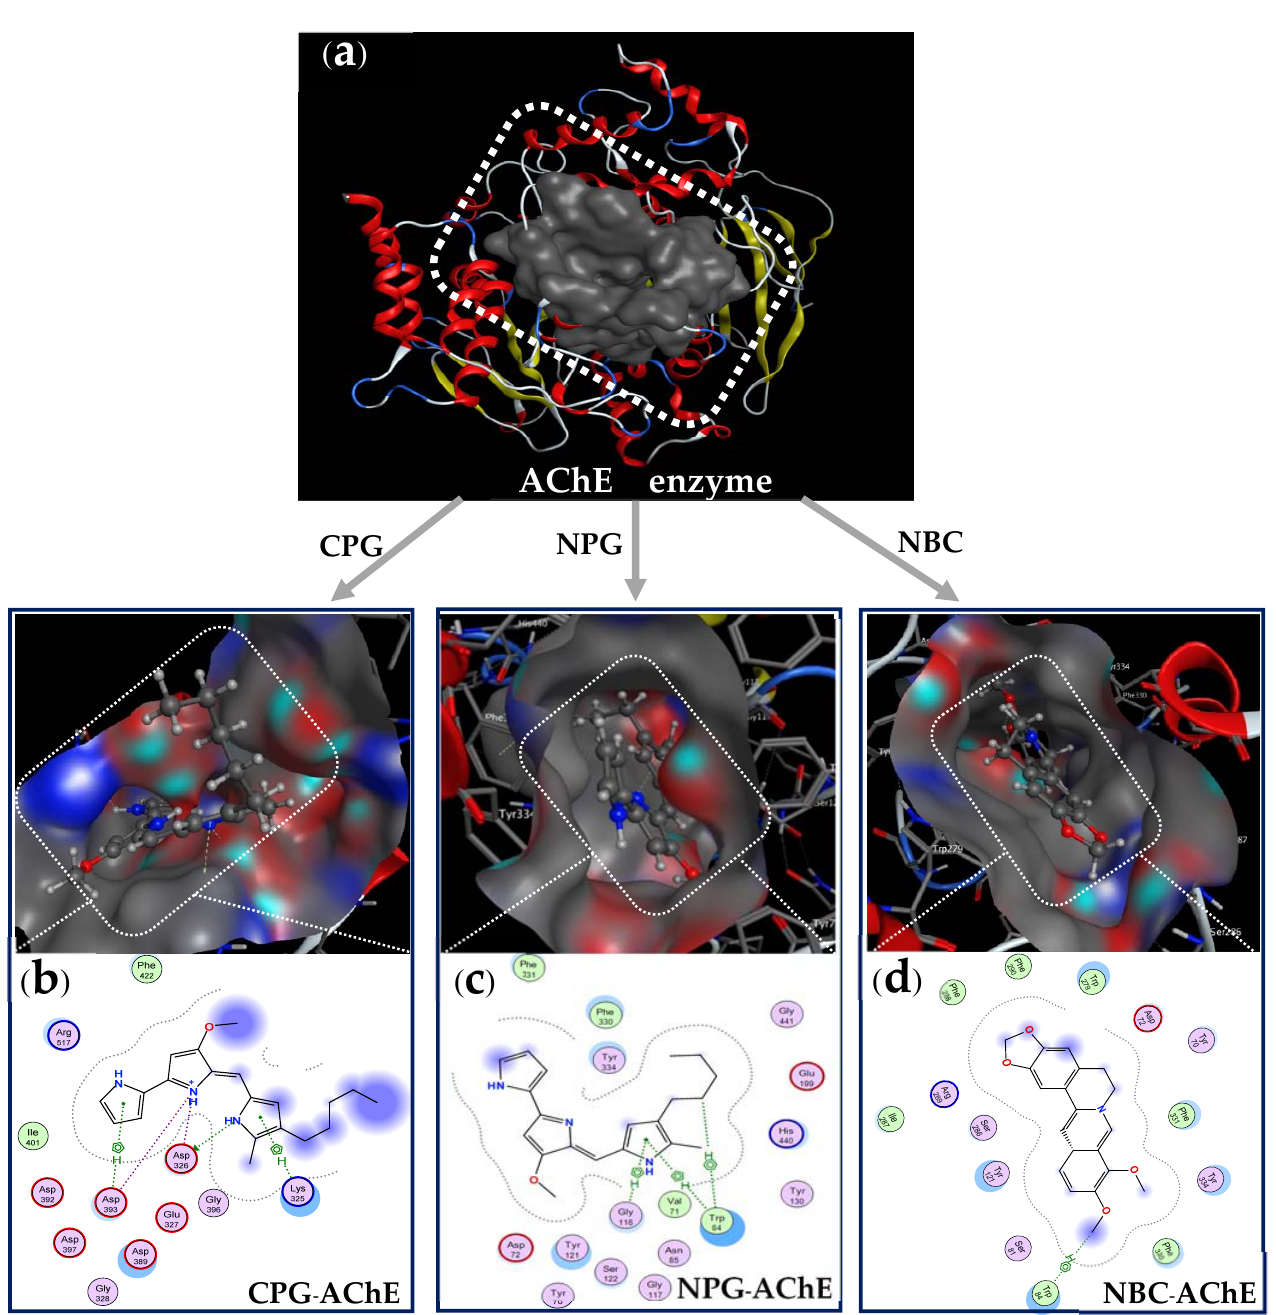
Figure 8. The 3D structures of binding site on AChE enzyme ( a ). The interactions between the ligands (cation-PG, neutral-PG, and neutral-BC) and the AChE enzyme, labeled as CPG-AChE ( b ), NPG-AChE ( c ), and NBC-AChE ( d